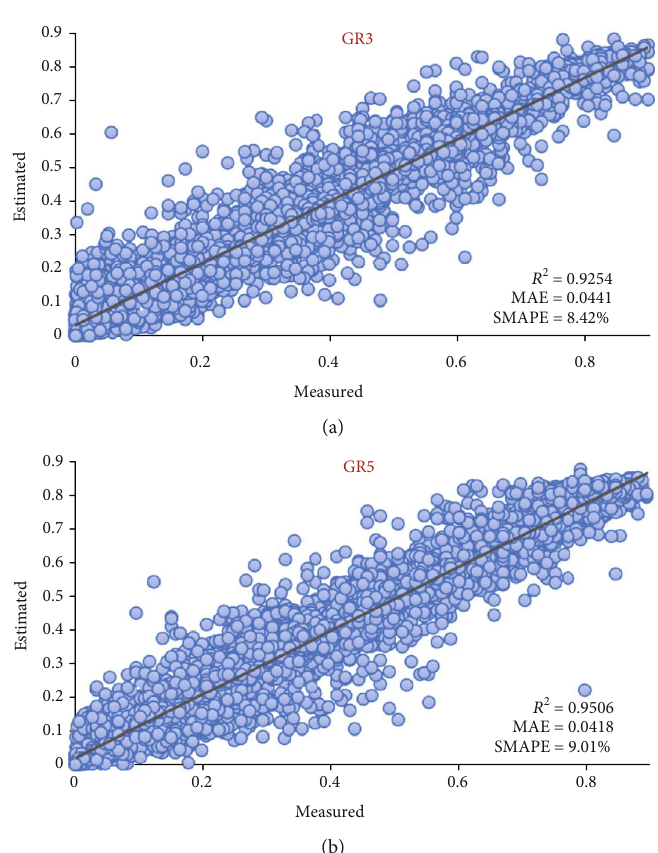
Figure 14: Scatter plots of the M5 rules-based most successful models according to (a) GR3 input data for Isparta and (b) GR5 for Kahramanmaras.